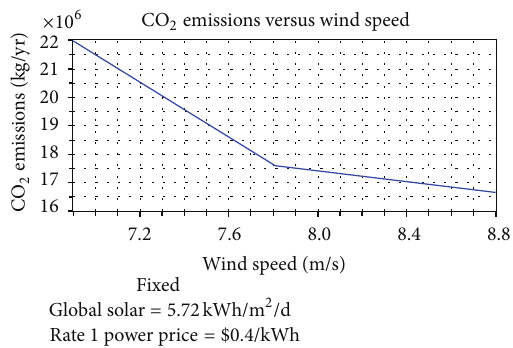
Figure17:TherelationshipbetweenCO 2 emissionsandwindspeed.